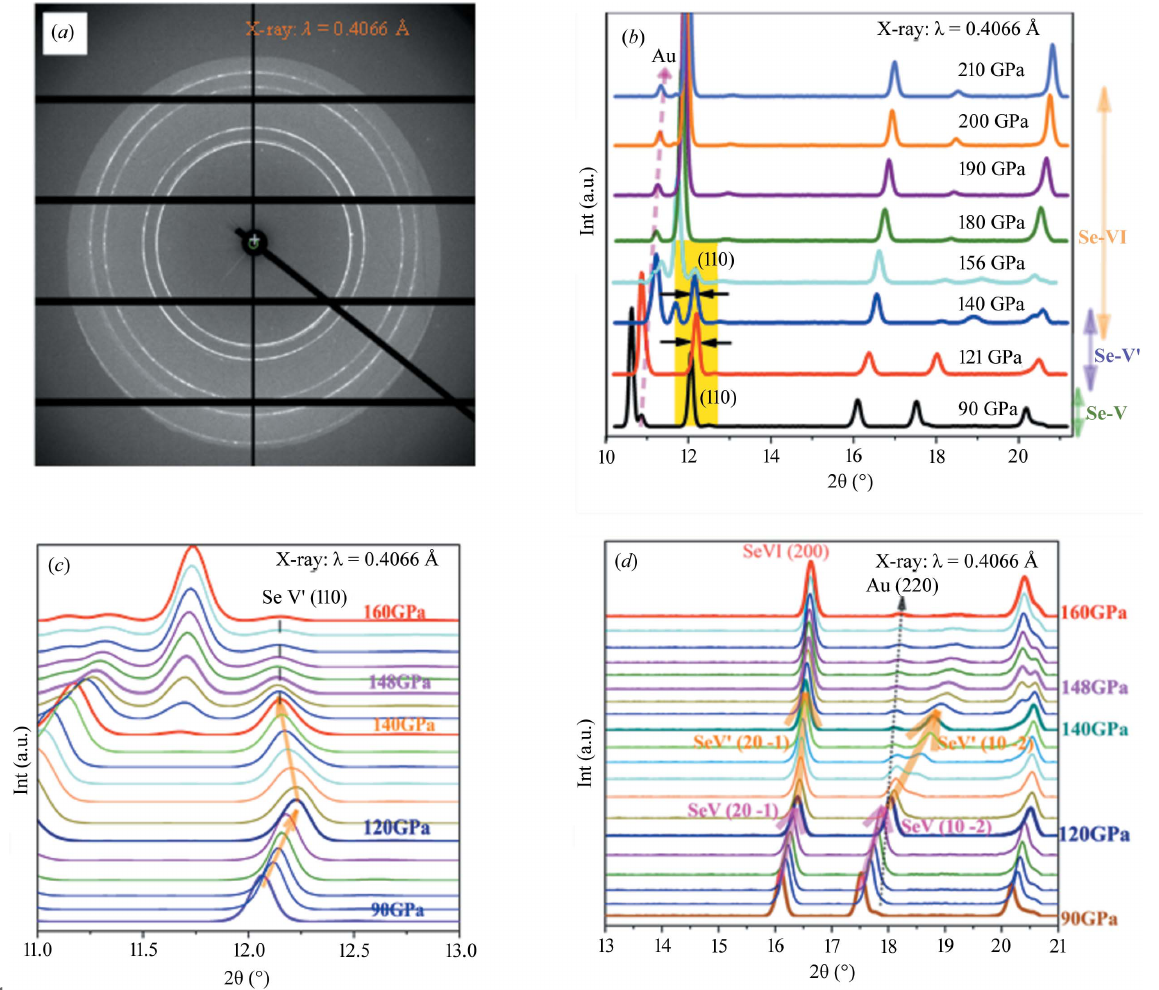
Figure 1 ( a ) 2D diffraction image of Se under 90 GPa pressure. ( b ) XRD patterns of Se compressed under selected pressures from 90 to 210 GPa at ambient temperature, evolving from Se-V to Se-V 0 , then to Se-VI. A zoomed-in view of ( b ) with more XRD patterns added between the plotted ones, from 90 to 160 GPa, of 2 (cid:3) ( c ) 11 to 13 (cid:7) ; ( d ) 13 to 21 (cid:7)